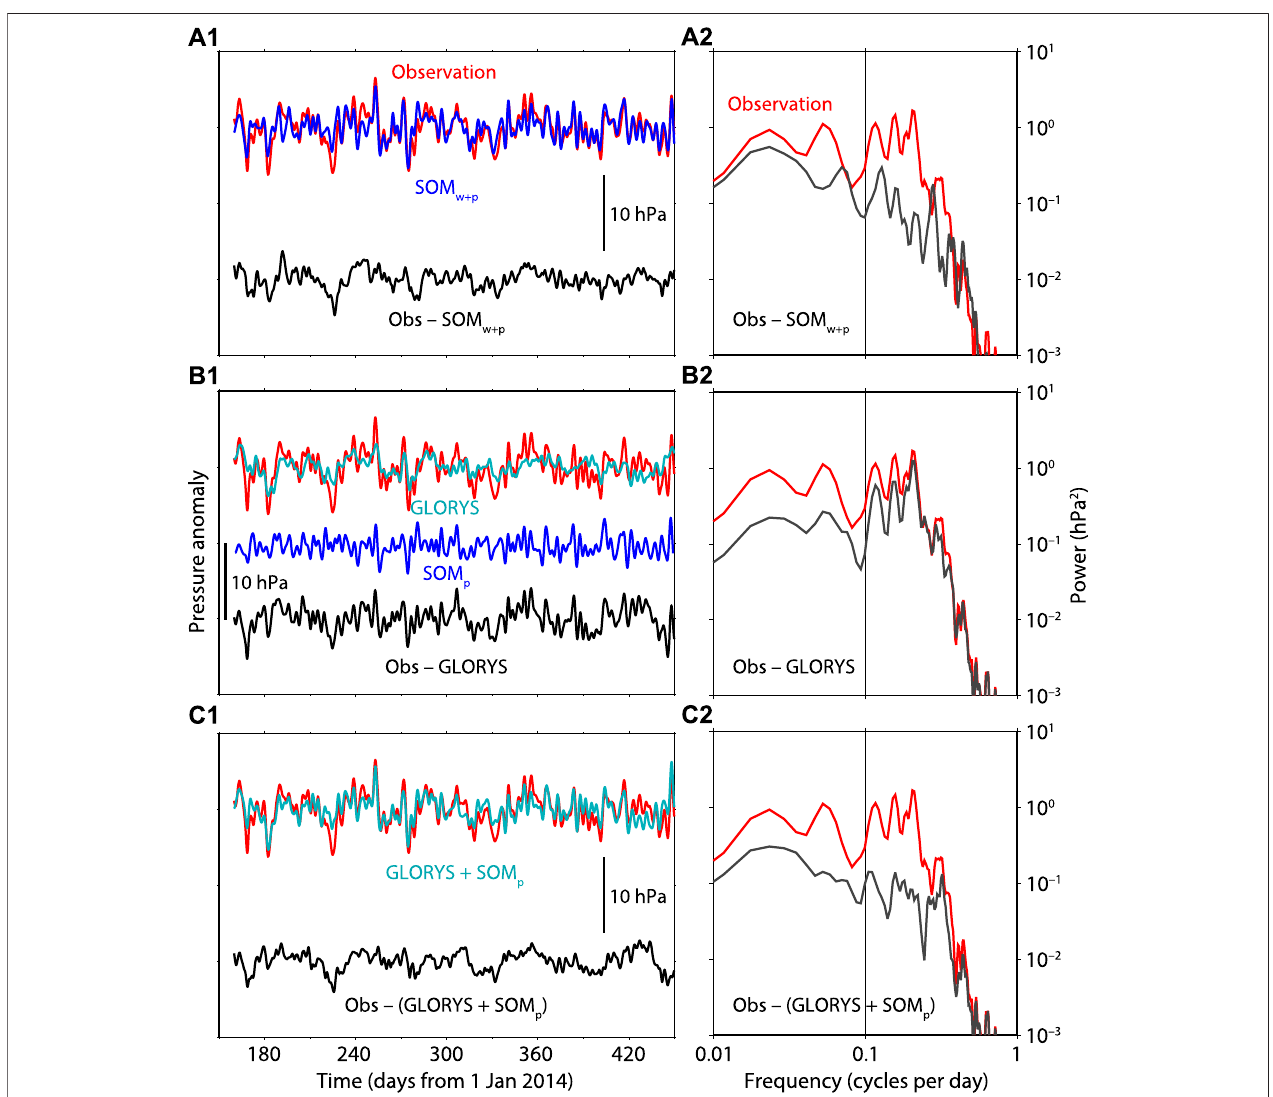
FIGURE 5 | Comparison of observed and modeled ocean bottom pressure in time (left) and frequency (right) domains. Red and black indicate observation and residual(observationminusmodel),respectively.BlueandcyanindicateSOMandGLORYS,respectively.ThisisanexampleofLOBS10( – 39.1333 ° N178.3132 ° E)atthe Hikurangi